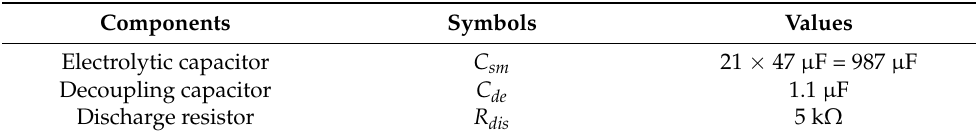
Figure 10. Power circuit board: ( a ) top view; ( b ) bottom view. Table 1. Power circuit board components.